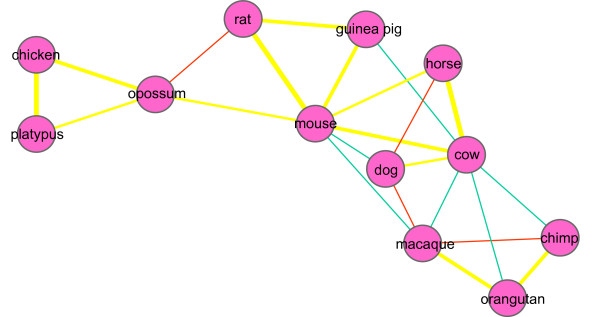
A network of fast-evolving and slow-evolving genes among twelve mammalian species. For any two given species, we calculated the shared number of fast-evolving or slow-evolving genes and subsequently divided them based on the total shared number of genes to normalize the correlation coefficients. We connected the species based on the largest two correlation coefficients for each pair. Red and green lines stand for fast-evolving and slow-evolving genes, respectively, and the yellow lines are the sum of both.